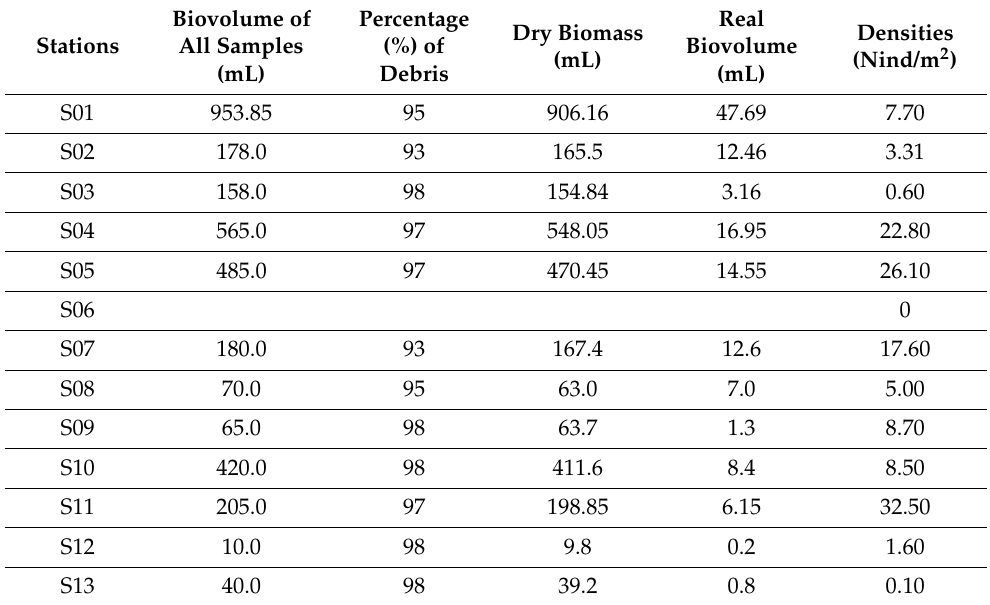
Table 3. Estimations of the dry biomass, percentage of debris, real biovolume, and the density of benthic fauna at the 13 sampling stations located along the maritime canal connecting Ziguinchor port to the sea.